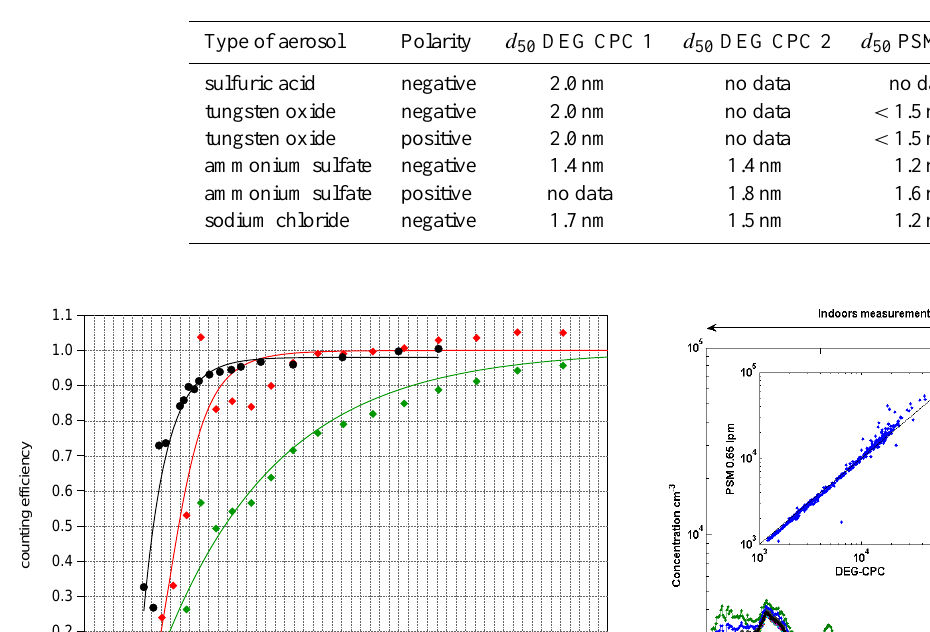
Table 2. Summary of the 50% detection efficiencies of the four CPCs for different types of aerosols. When using tungsten oxide as test aerosol the smallest size that can be produced was about 1.5nm, where the PSMs still detected roughly 60%.